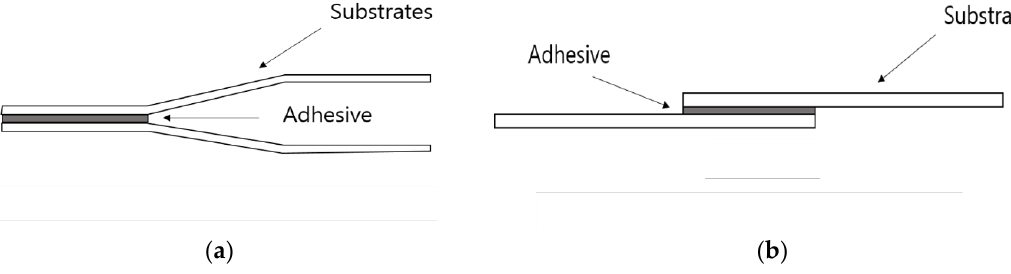
Figure 2. Applied adhesive on ( a ) the impact wedge-peel (IWP) test specimen; and ( b ) the single lap joint (lap shear) test specimen.